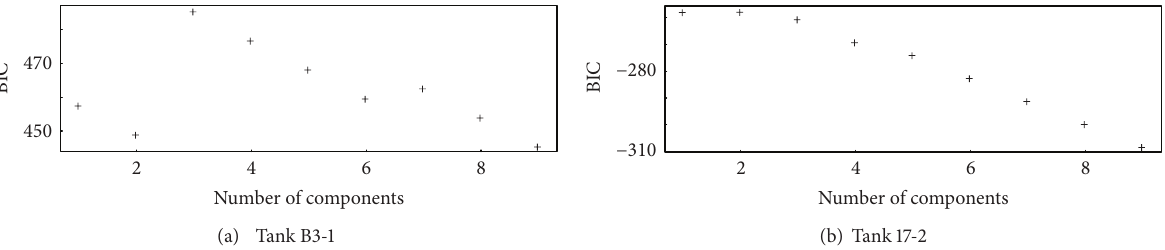
Figure 13: The BIC values versus candidate number of components for the 73 wait mode residuals in tank B3-1 and the 74 wait-mode residuals in tank